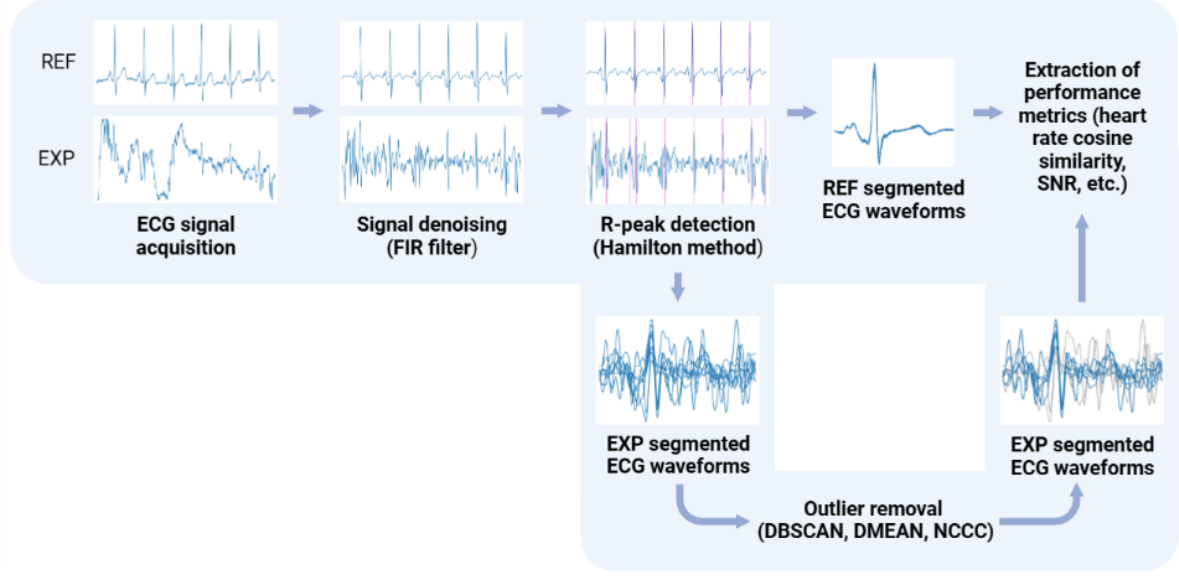
Figure 5. Processing pipeline for the ECG signals acquired with the reference sensor (REF) and the proposed “invisible” system (EXP). Created with